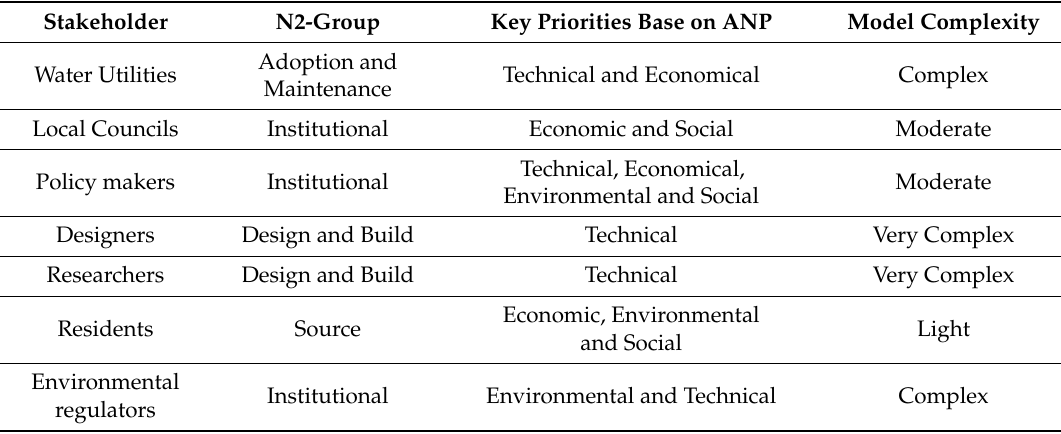
Table 3. Classification of stakeholders involved in SuDS and the desired level of modelling complexity. Stakeholder Key Priorities Base on